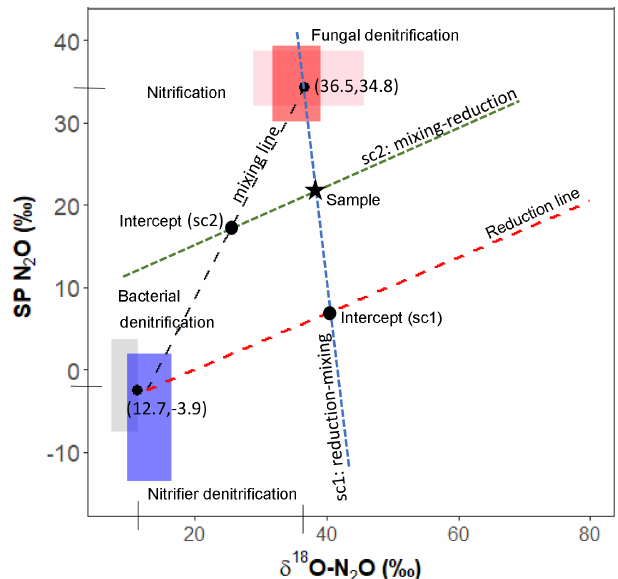
Figure 1. Mapping approach scheme used in the closed-system modeling. Adapted from Lewicka-Szczebak et al.